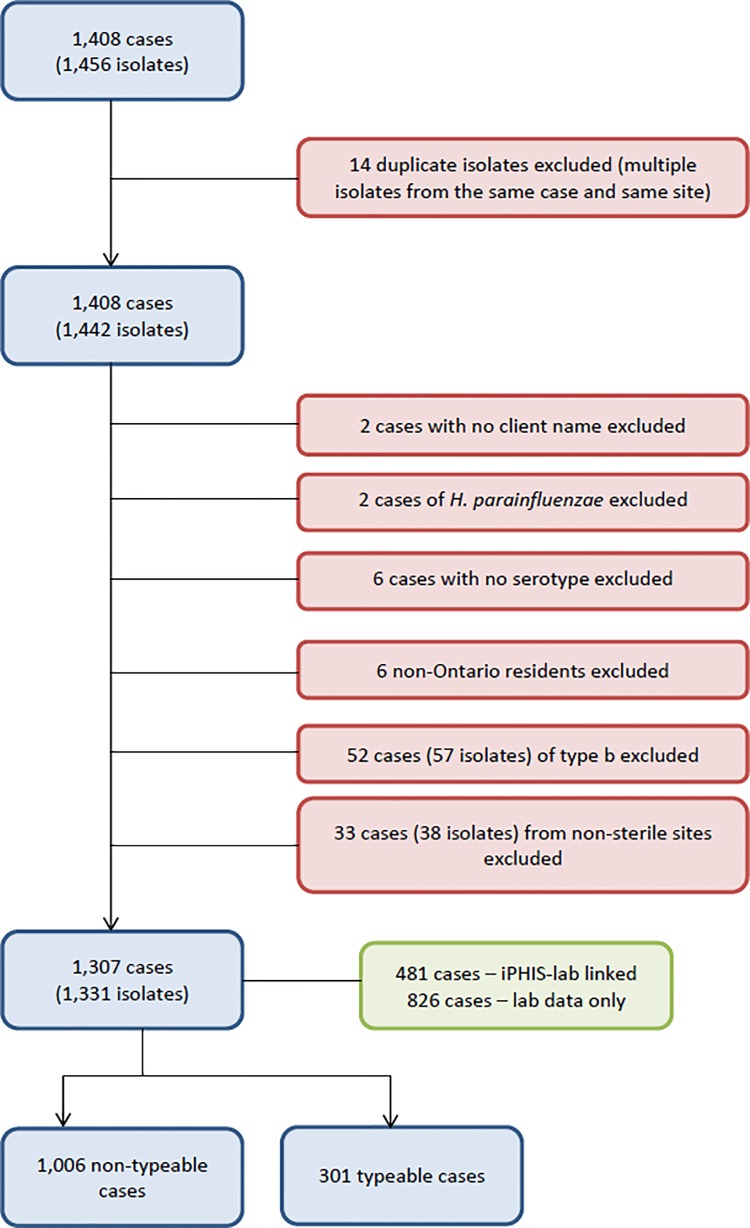
Data abstraction, cleaning and linkage for non-Hib cases 2004–2013, Ontario, Canada.